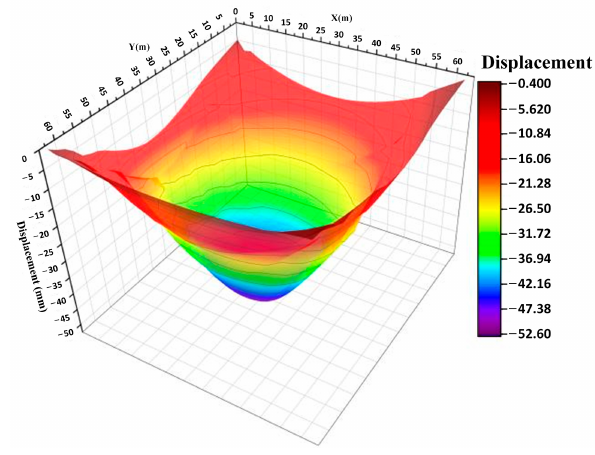
Figure 11. Cave-in zone in model.